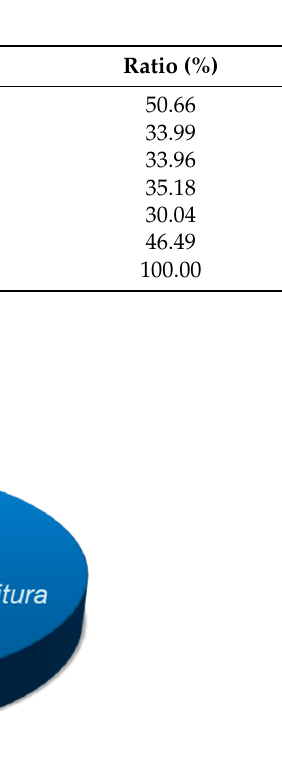
Table 3. Unigenes annotation against six public databases (DB).